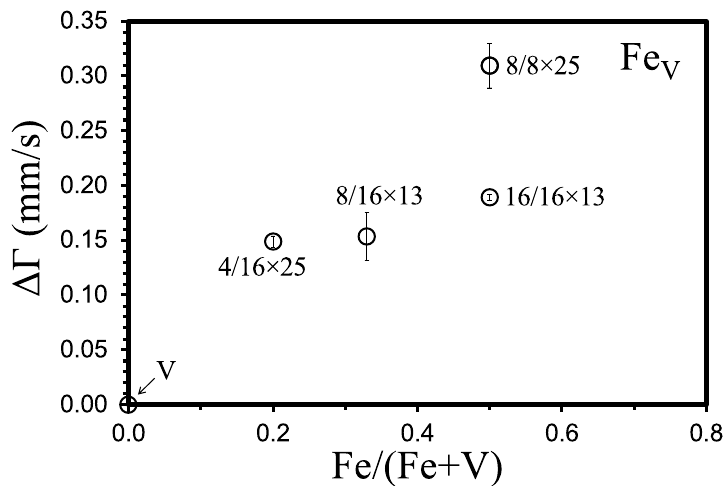
Figure 10. The additional Lorentzian broadening of the Fe V spectral component in the eMS spectra from the pure V-layer and the Fe/V superlattices as indicated from Table